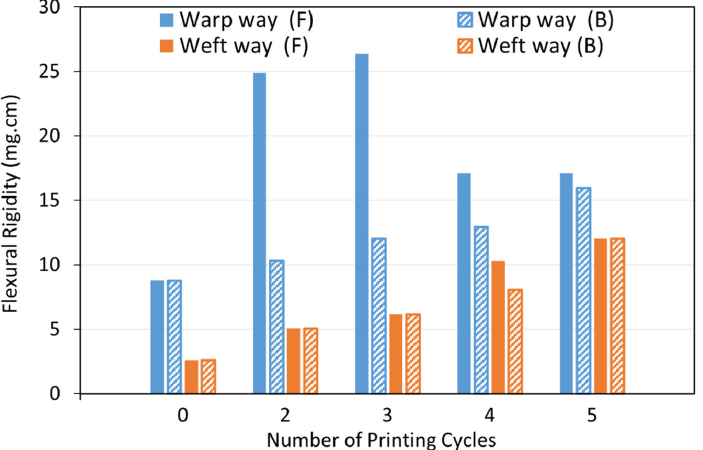
Figure 10. Flexural rigidity of the face (F) and back (B) side of the metallised textiles printed with the Cu–Ag NP catalyst at different numbers of cycles and directions.